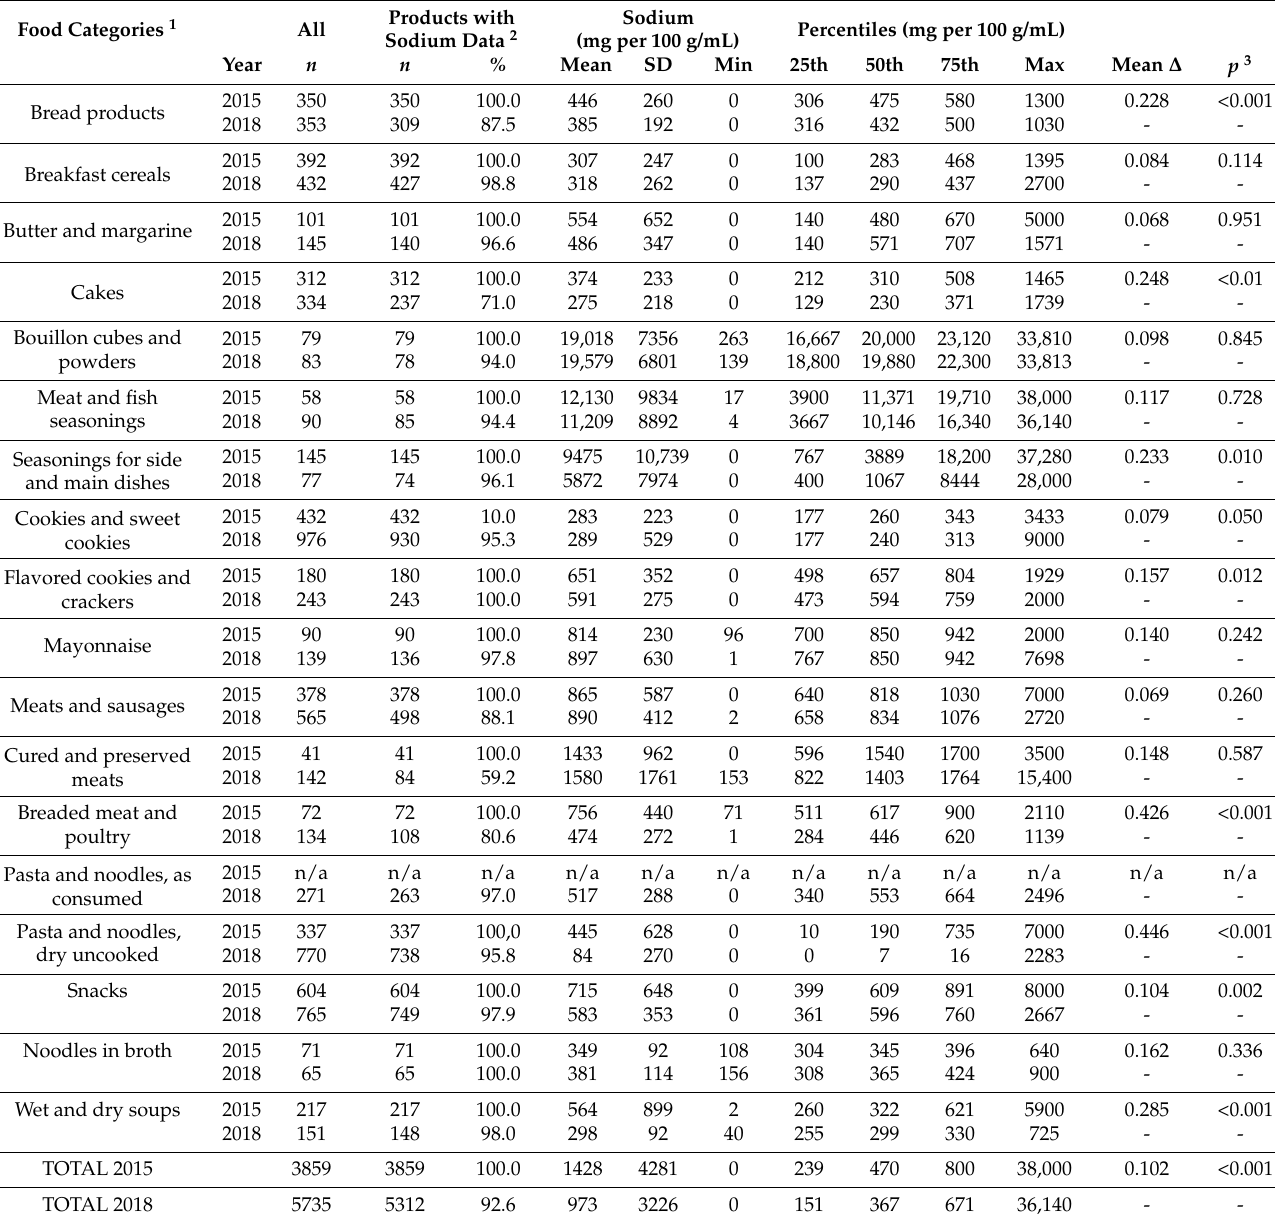
Table 2. Changes in the sodium content of packaged foods (mg per 100 g) in Argentina, Costa Rica, Paraguay, and Peru between 2015–2016 and 2017–2019 ( n =